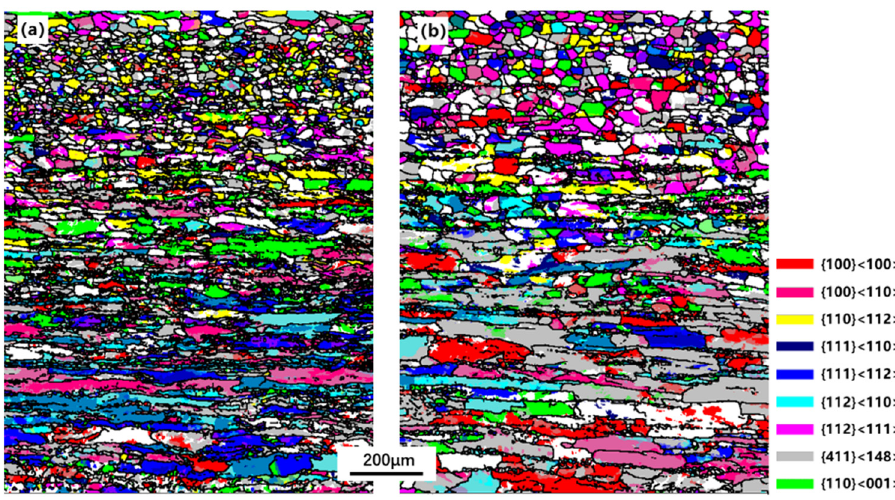
Figure 11: Grain orientation diagram of hot - rolled sheets: ( a ) Y - free and ( b ) Y - bearing.